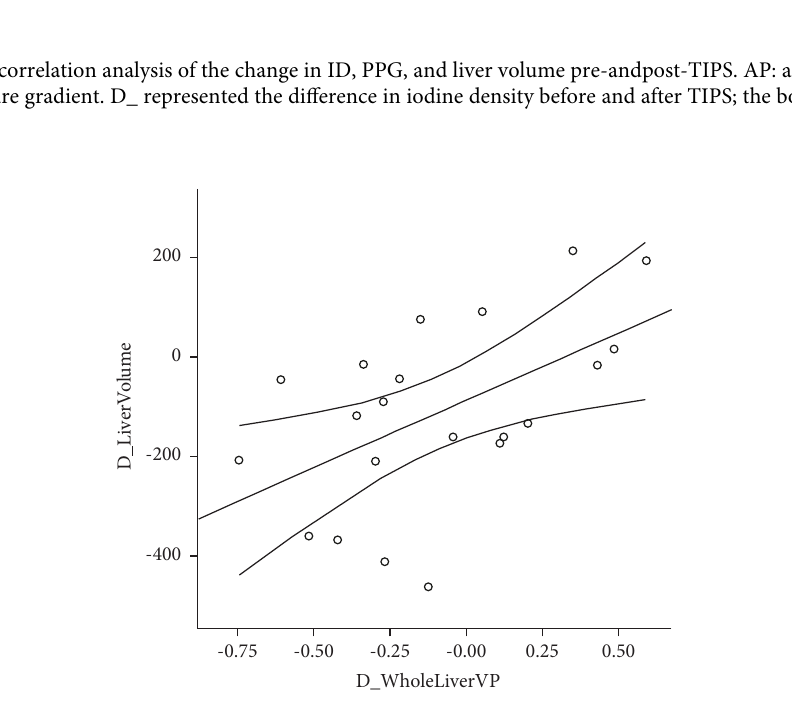
Figure 2: Scatter plots between the change of whole liver parenchyma iodine density at venous phase (D_WholeLiver VP) and the change of liver volume (D_LiverVolume).